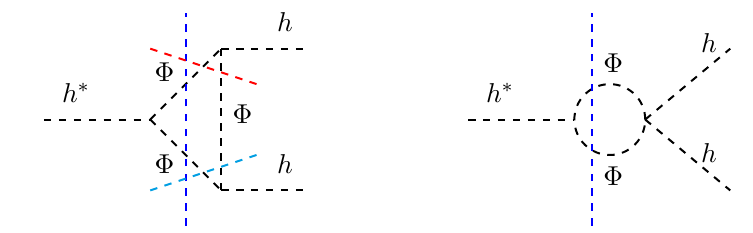
Figure 6 . One-loop topologies contributing to the modification of the trilinear Higgs boson vertex within the fIDM. The dashed colored lines indicate the different thresholds that vanish identically for the fakeon quantization